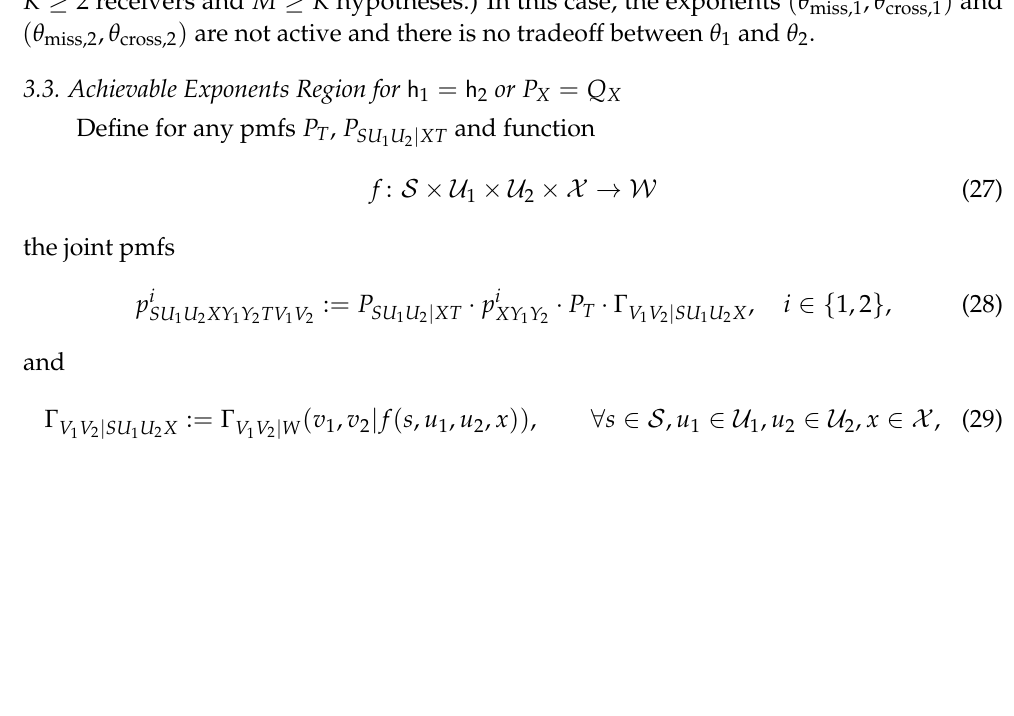
case. Exponent θ cross, i corresponds to the event that the transmitter sends a codeword from { W ( j ; m ) } , for j = 3 − i , but Receiver i decides that a codeword from { W ( i ; m ) } was sent and a source codeword S ( i ; m , (cid:96) ) satisfies the minimum conditional entropy